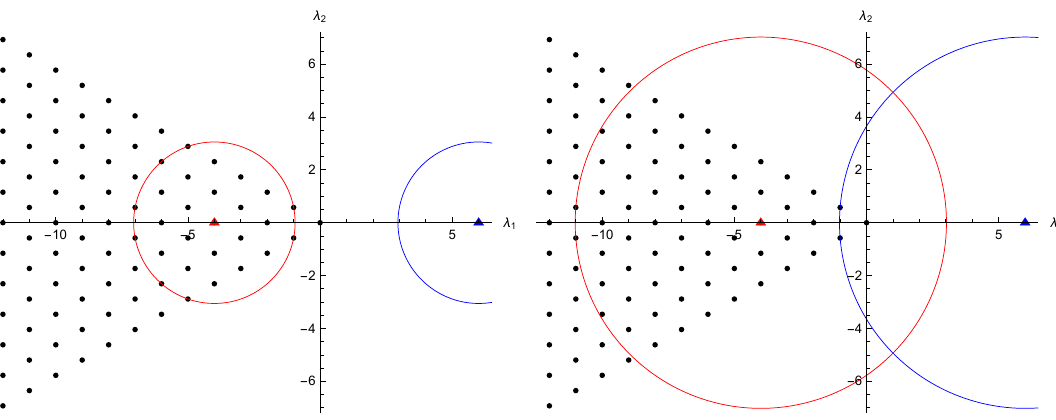
Figure 1 . States (black dots) and \energy shells" (blue for g =3, red for g = (cid:0) 2) in weight space for E = 28 (left) and E = 148 (right). 3 3